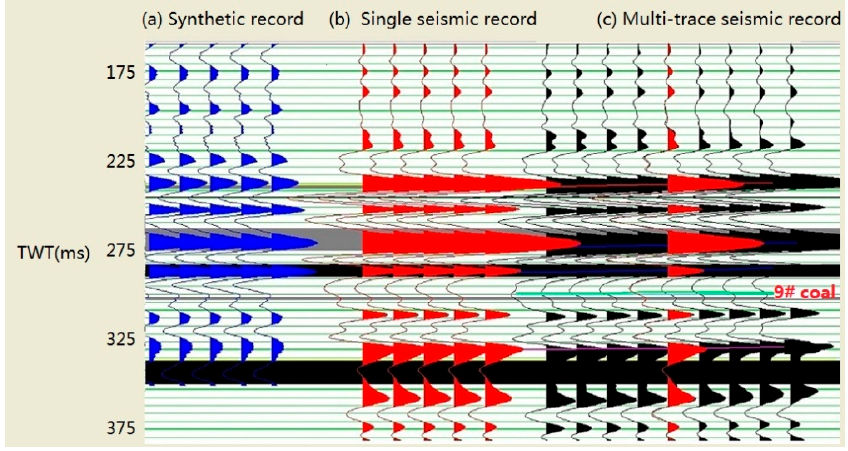
Figure 8. Synthetic record and seismic record.